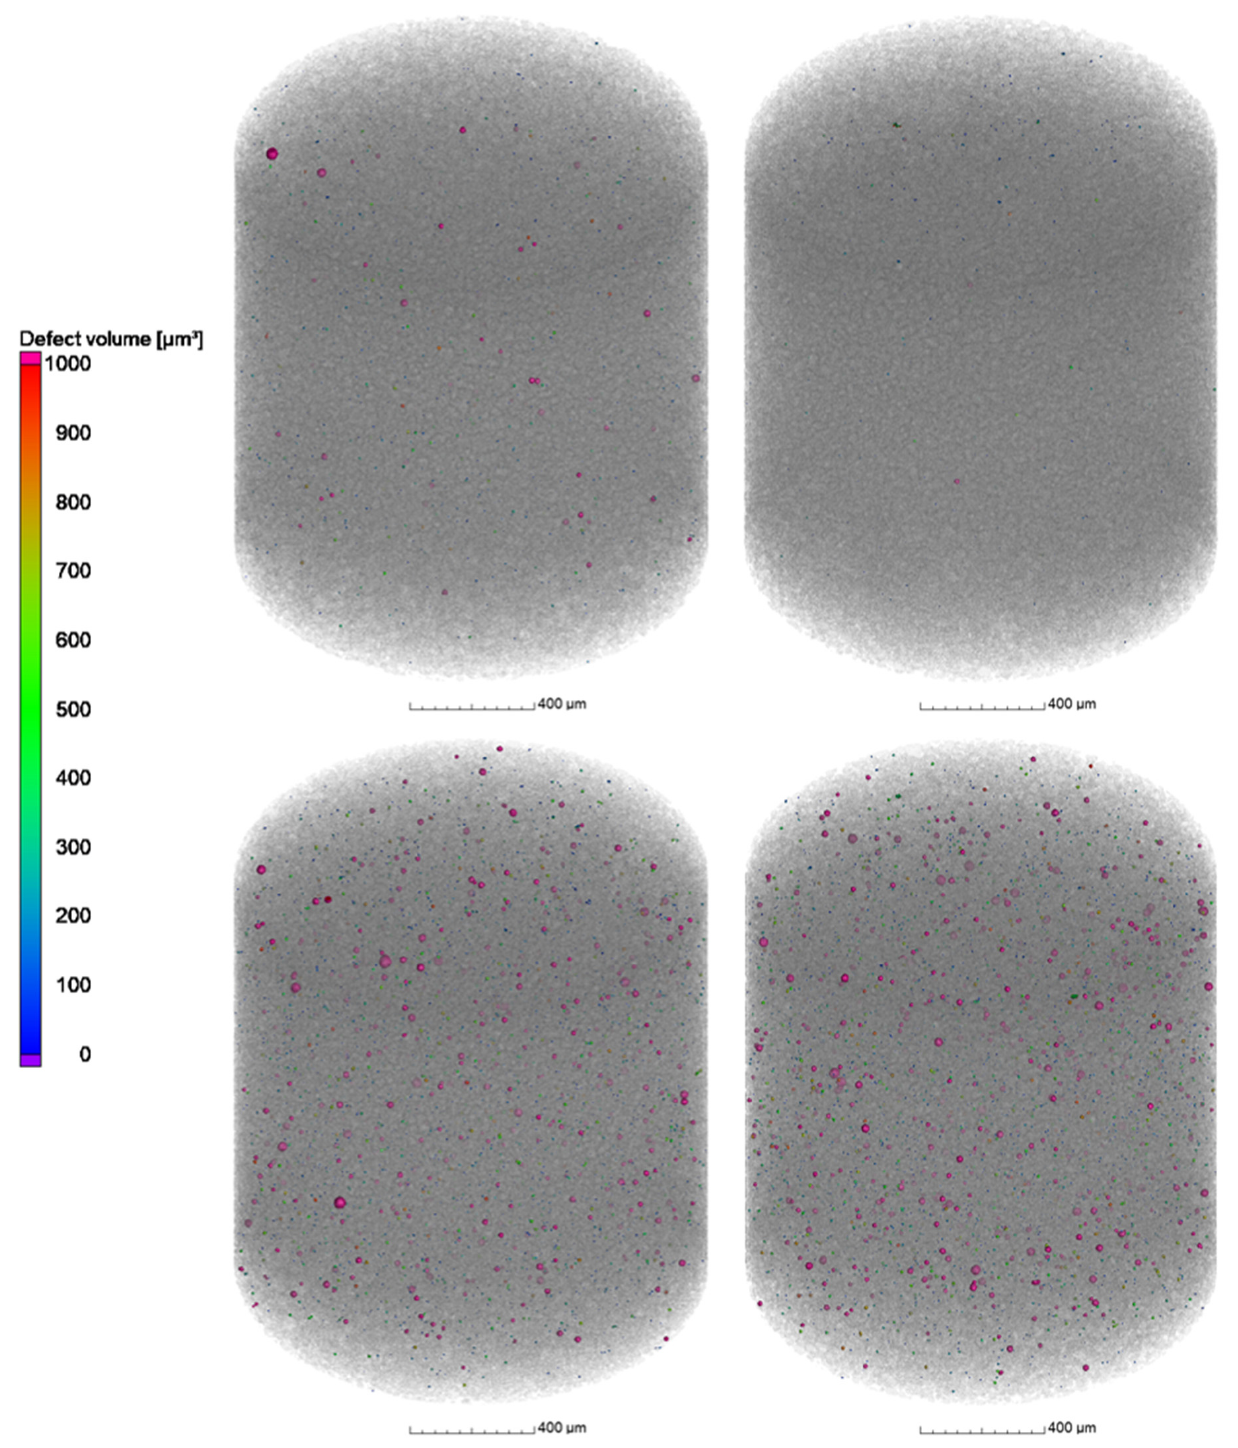
Figure 8. 3D-View of porosity of gas-atomized X2CrNiMoCuWN25-7-4 powders (particle size 20–63 µm, voxel size 1.56 µm). Top left: N 2 /N 2 -RT; Top right: N 2 /N 2 -330 °C; Bottom left: Ar/Ar-RT; Bottom right: Ar/Ar-330 °C.